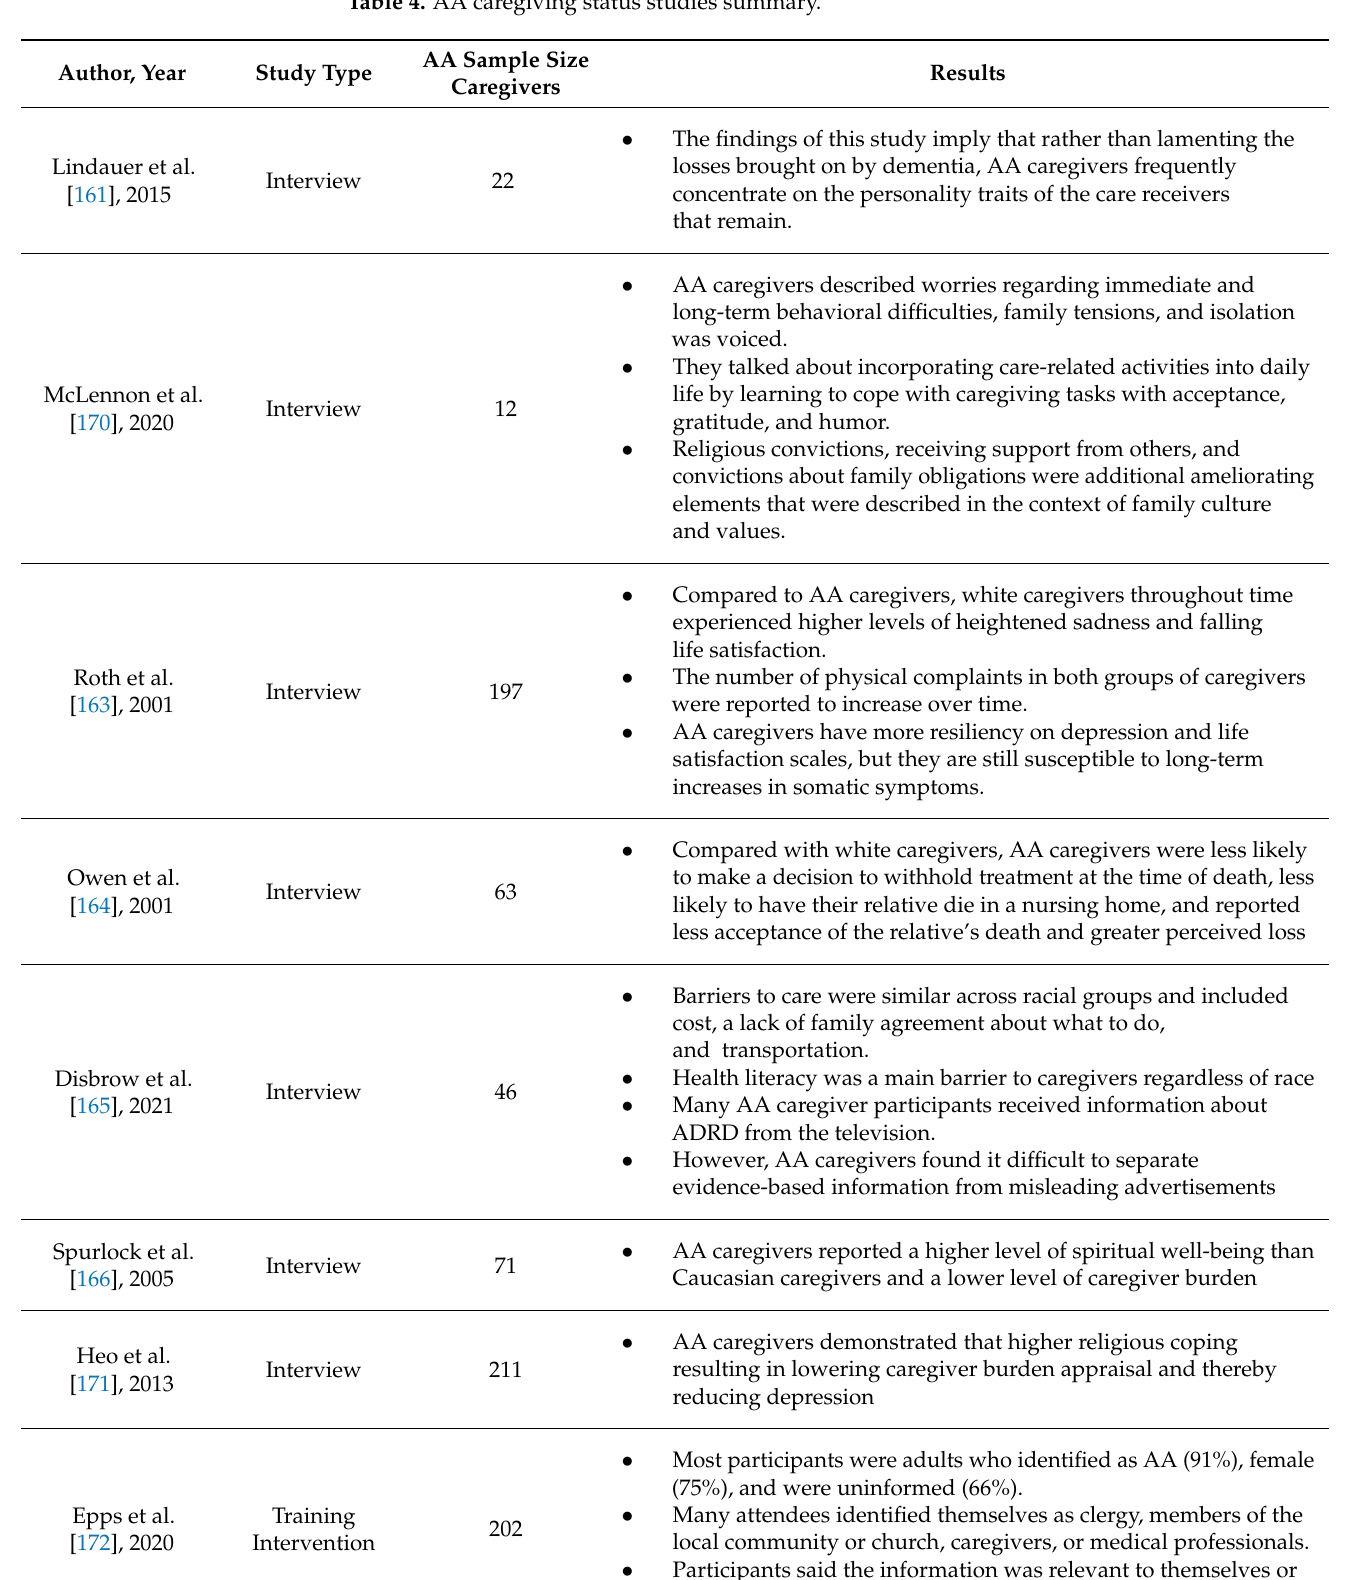
Table 4. AA caregiving status studies